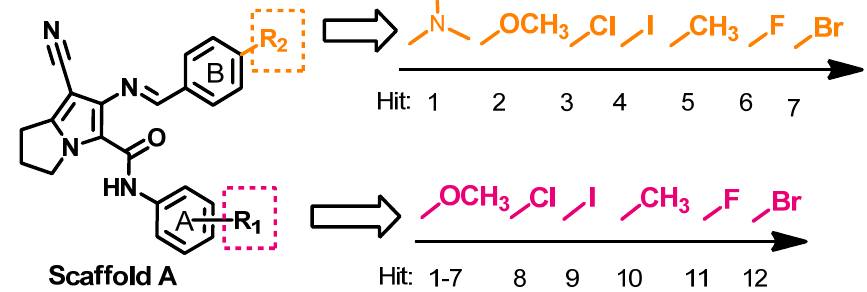
Figure 7. The order of substituents on the phenyl rings of the top fifteen hits. Although hit 4 , hit 9 , and hit 13 have displayed low RMSD values (Table 1), they have high molecular weights (>500 daltons). Considering the limits of Lipinski’s rule, the three hits will be excluded from the compounds selected for the chemical synthesis.